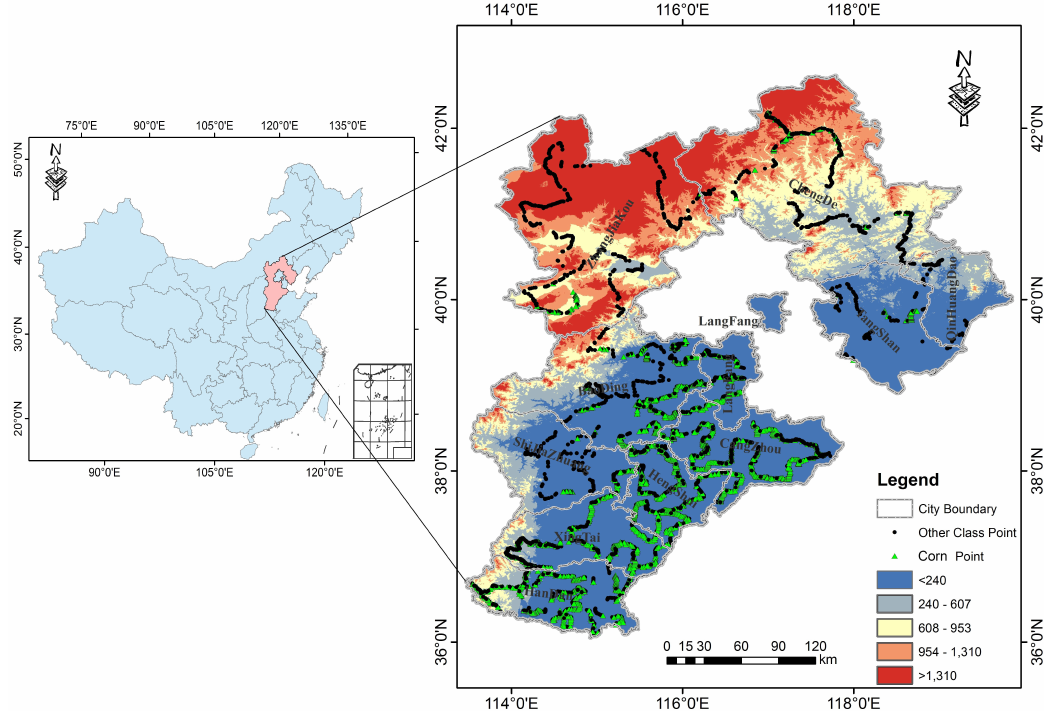
Figure 1. Hebei Province, including 11 prefecture-level cities, is the area of interest in this study. The topographical characteristics of Hebei Province and the field sample point location are shown in the map on the right. Corn points are labeled as green triangle symbols, while other class points are shown as black